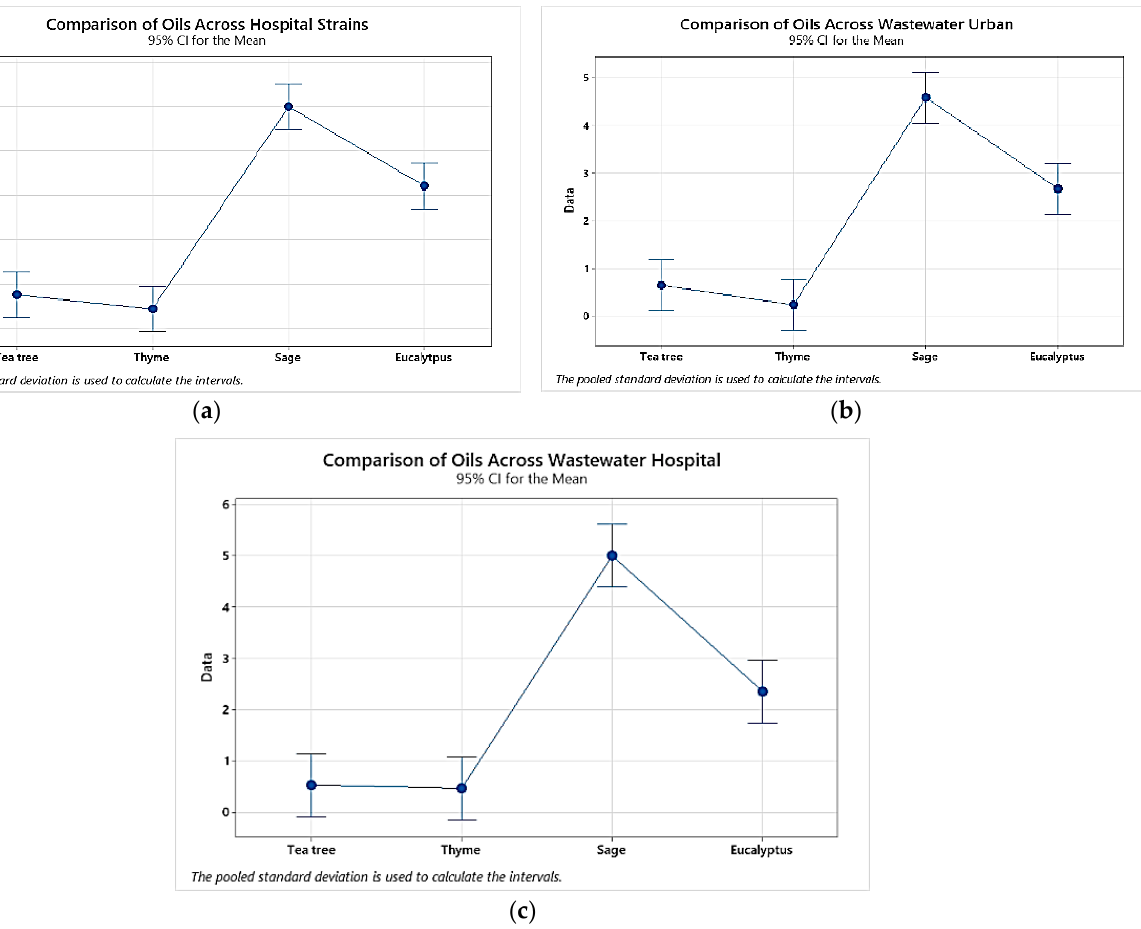
Figure 9. Charts showing comparison of the MIC values for the tested EOs among P. aeruginosa strains isolated from different sources: (a) comparison of EO MICs across hospital strains, (b) comparison of EO MICs across wastewater hospital, (c) comparison of EO MICs across wastewater urban; p < 0.05 when comparing average MICs of thyme or/and tea tree EOs to sage or/and eucalyptus.